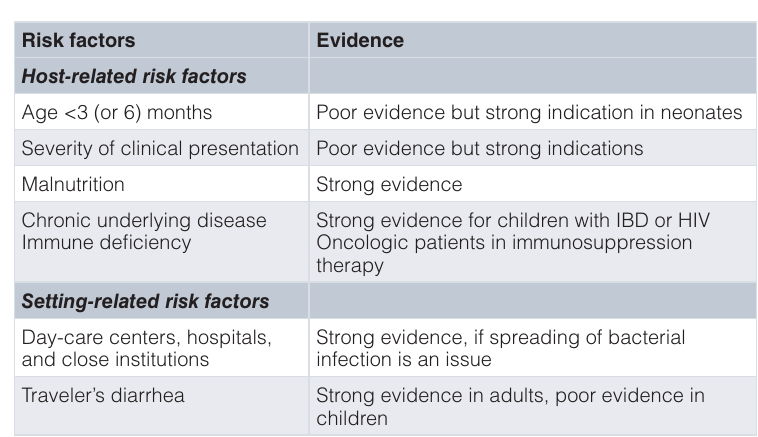
Table 2. Risk factors indicating antibiotic therapy in children with acute diarrhea.